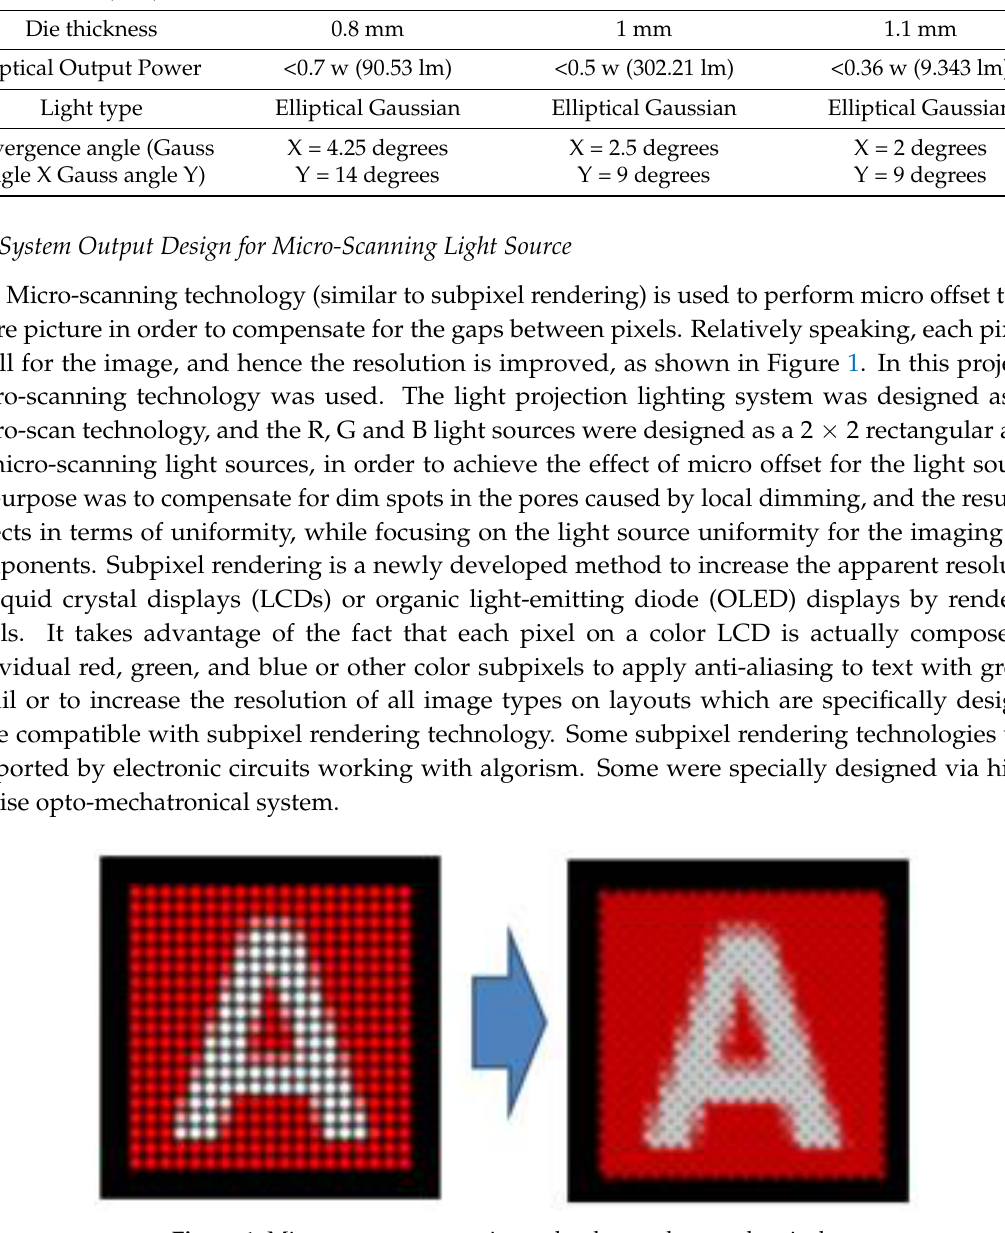
Figure 2. Optical path for green light source in a rectangular 2 × 2 array. The R, G and B light sources each had four laser diodes arranged in a rectangular manner, symmetrically aligned with the main axis. When the array distance is 5 mm, as shown in Figure 2, a